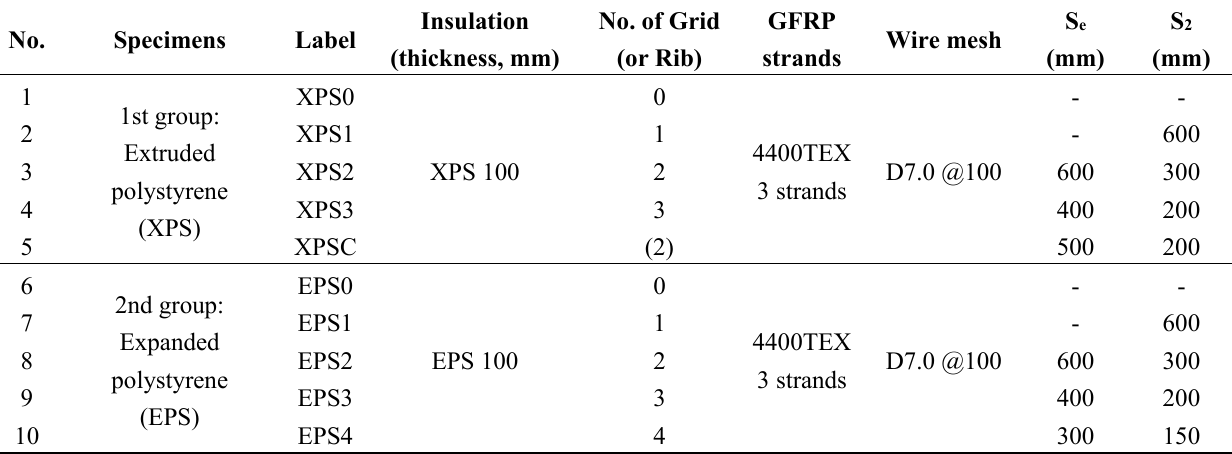
Table 2. Test specimen matrix.